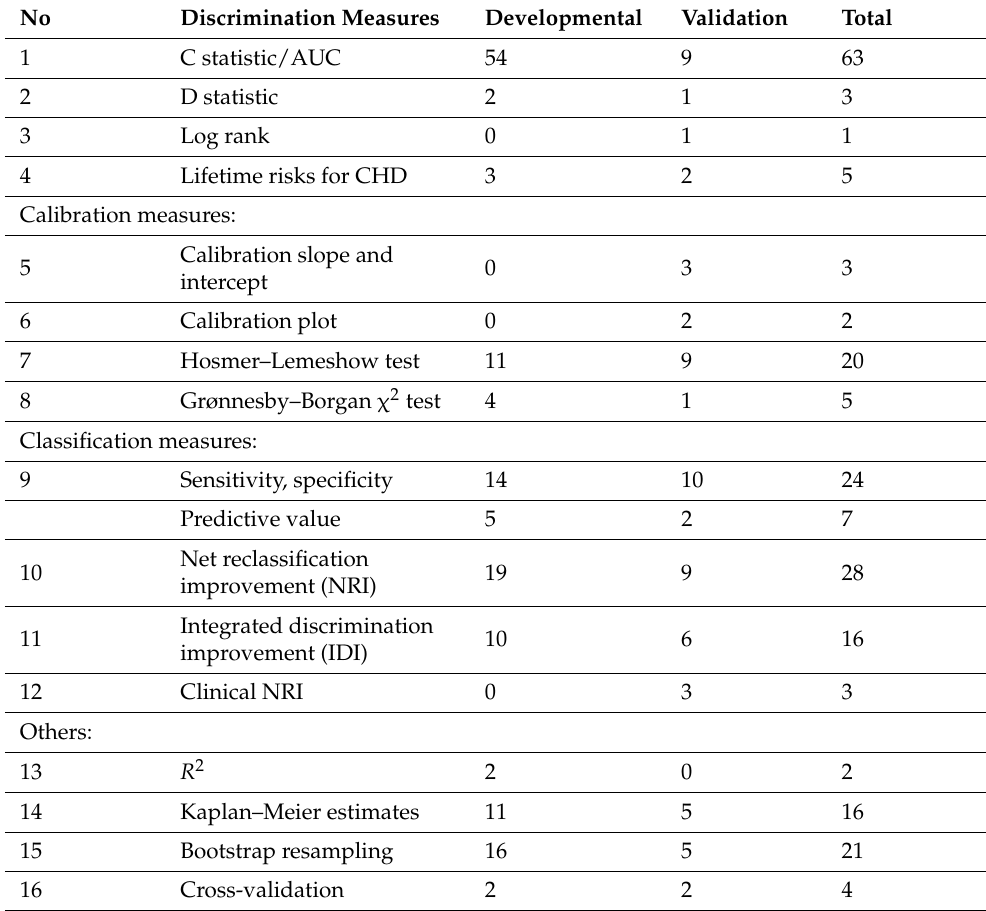
Table 2. The performance measures reported for the developed and validated